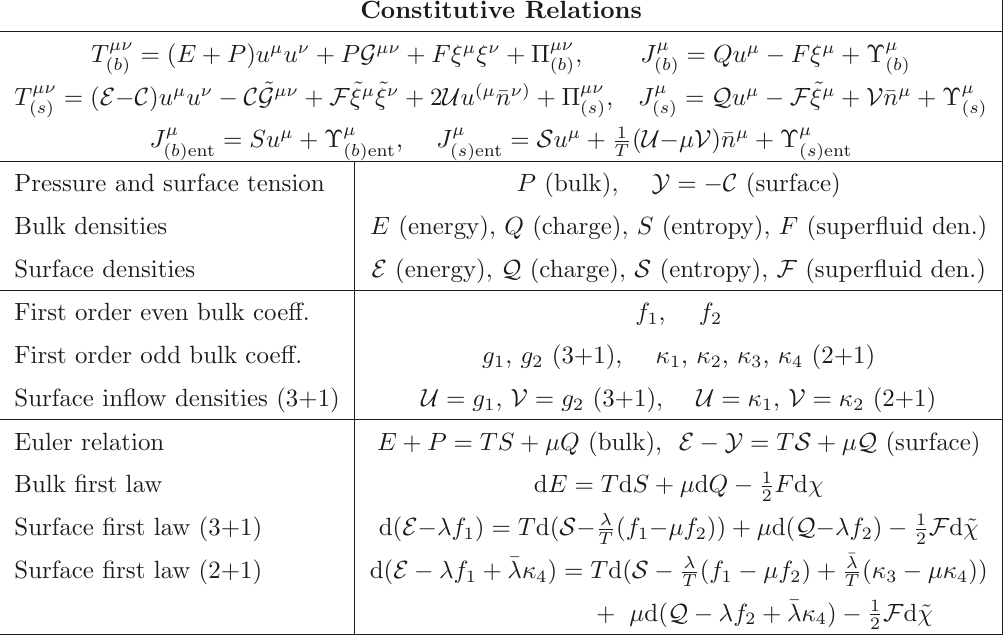
Table 4 . Quick reference guide for relativistic superfluid bubbles (Part